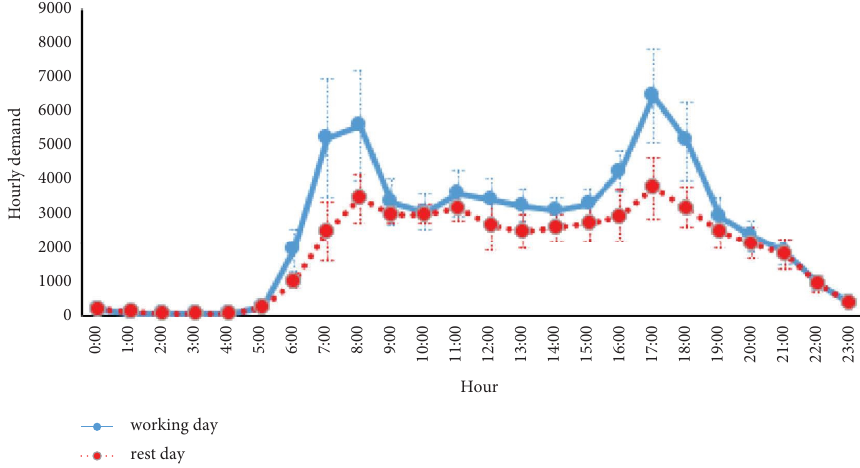
Figure 7: Te mean and variance of bike-sharing demand at diferent hours of a day.